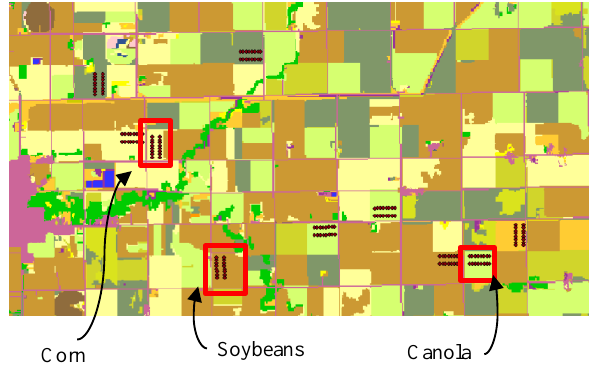
Figure.2 .The selected fields for Ground